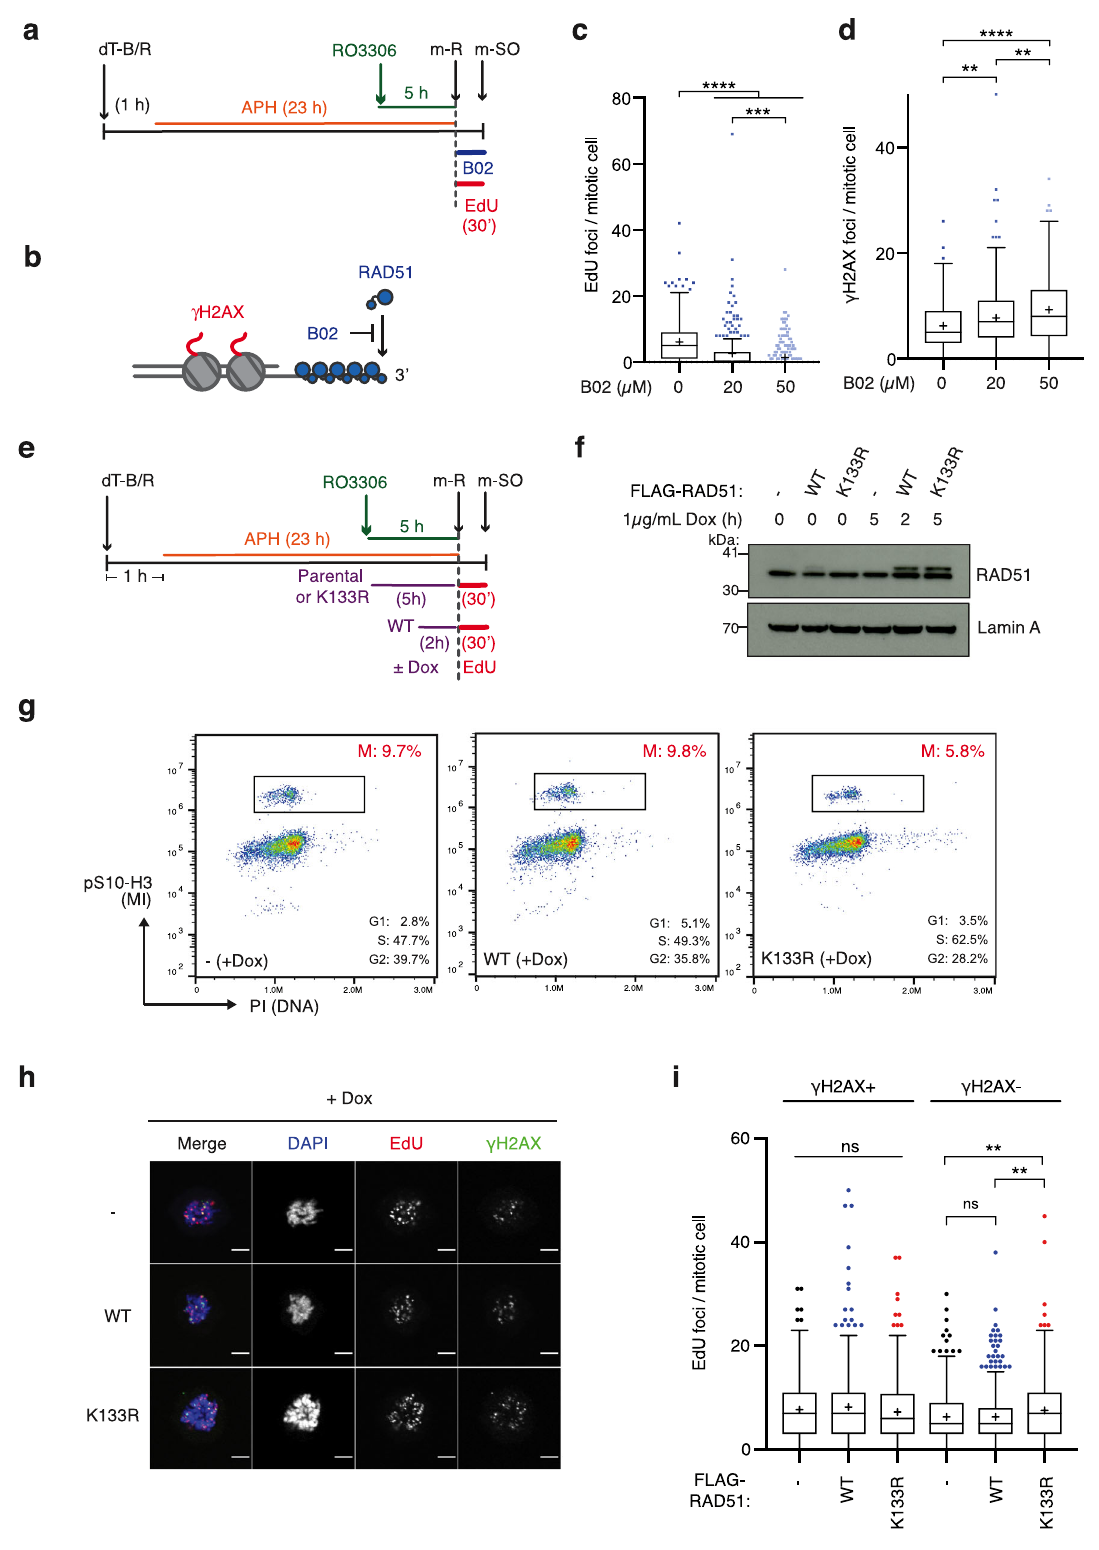
events at chromatin loci that are undamaged or escaped from canonical DDR, referred to as non-DDR-associated loci. Overall, these observations suggest that the nature of MiDAS varies signi fi cantly between different cell lines; MiDAS is largely associated with non-DDR loci in U2OS, but predominantly occurs at DDR- associated loci in HEK293